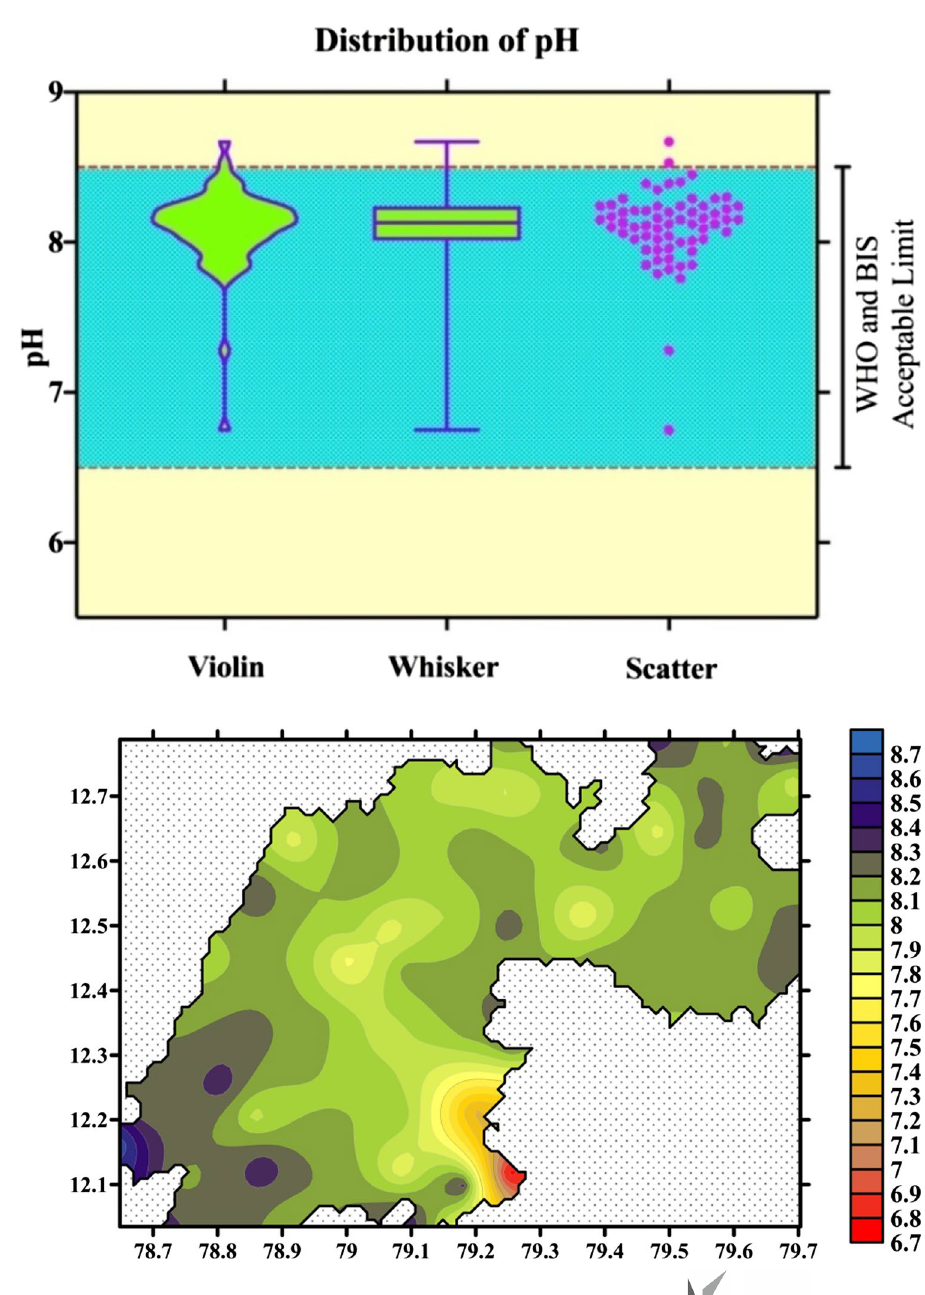
Fig. 5 Distribution of pH in the